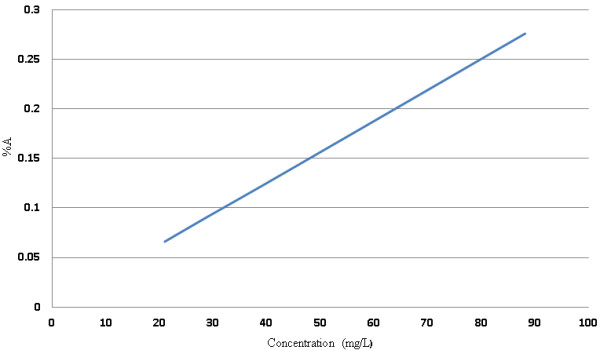
Molecular absorption curve in λmax 670 cm.